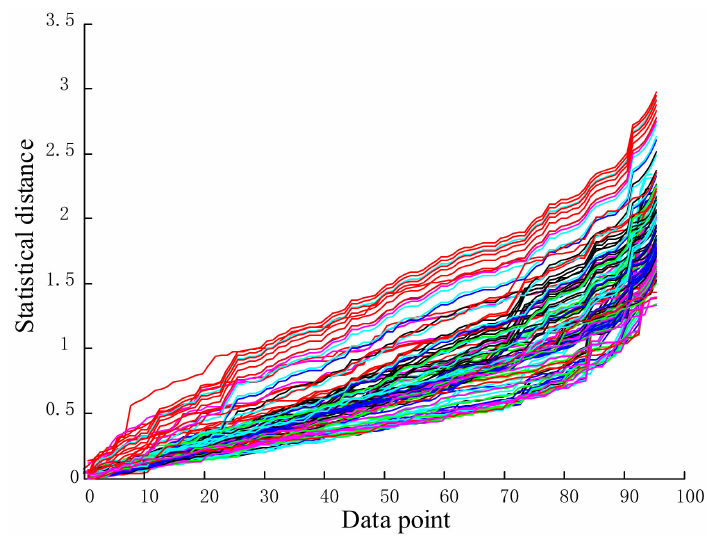
Figure 1. Distance curve